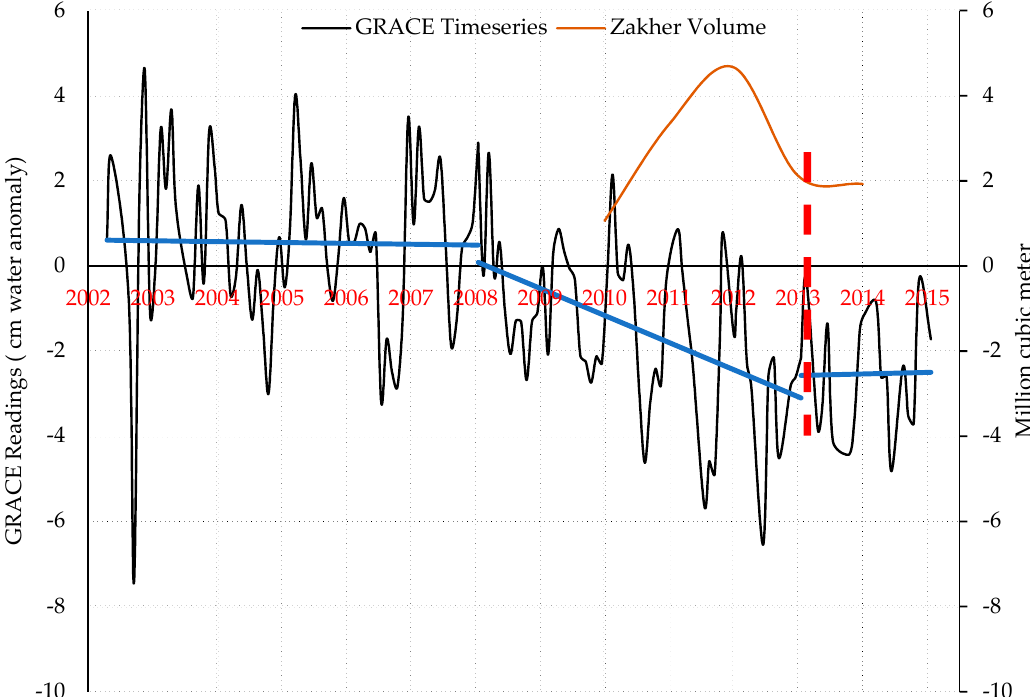
Figure 7. The Lake Zakher Volume (Mm 3 ) versus the GRACE time series anomalies (left axis); the dashed vertical line shows the timing of the second change point in the time series that coincides with the stabilization of the Lake Zakher water volume (Right axis).